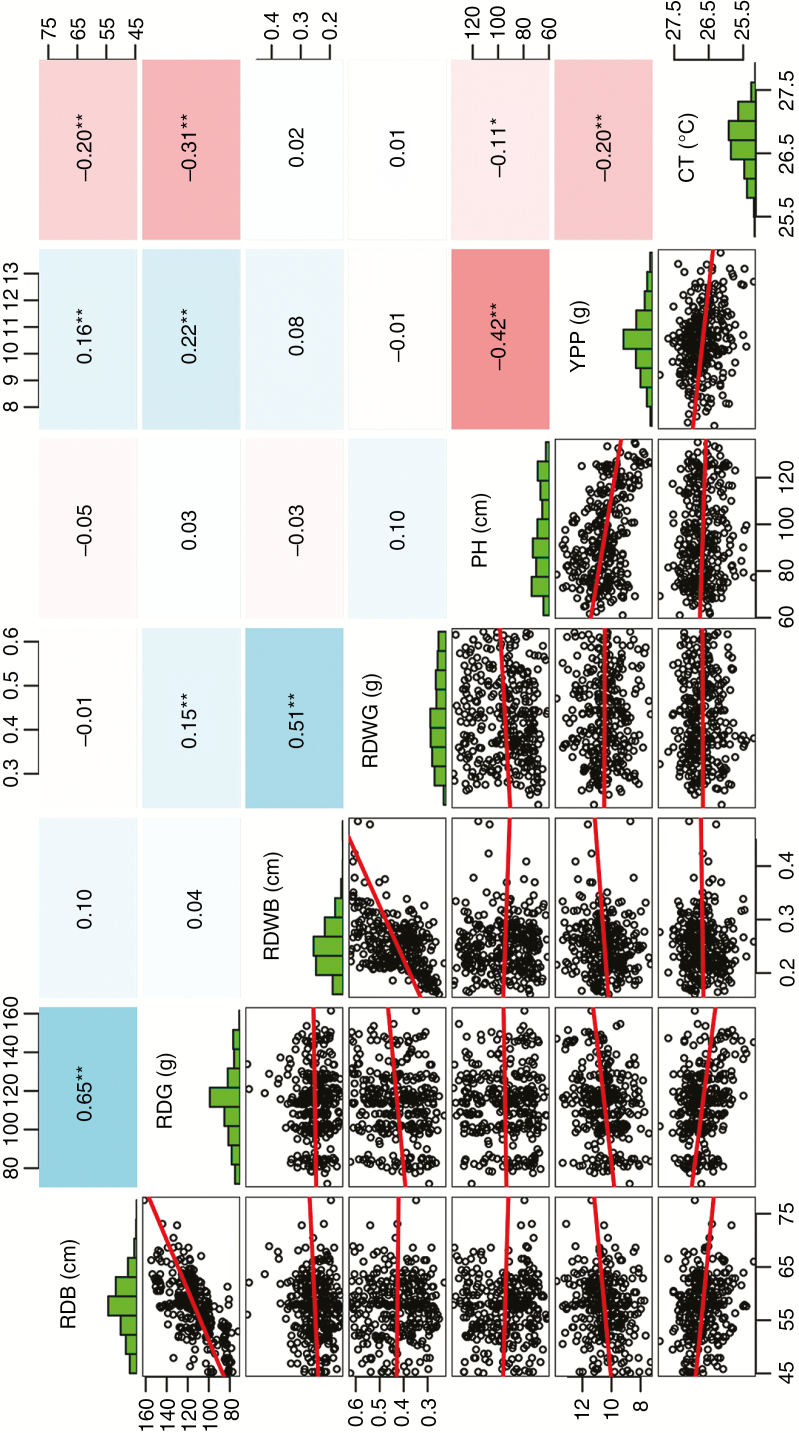
Correlation analyses and frequency distributions of root and shoot traits. The bottom left part of the matrix shows scatter plots of root and shoot traits; red lines indicate linear regressions. The upper right section shows correlation coefficients; colour shading indicates levels of correlation; and the diagonal shows histograms of different traits. RDB, root depth at booting; RDWB, root dry weight at booting; RDG, root depth at mid-grain fill; RDWG, root dry weight at mid-grain fill; PH, plant height; YPP, yield per plant; CT, canopy temperature; **P < 0.01.